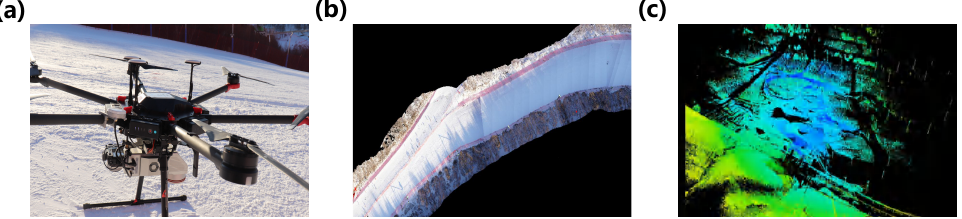
Figure 4. A UAV LiDAR system used to collect data: ( a ) represents the lidar system; ( b ) point clouds from the Wanlong Ski Resort; ( c ) point clouds from the National Cross Country Skiing